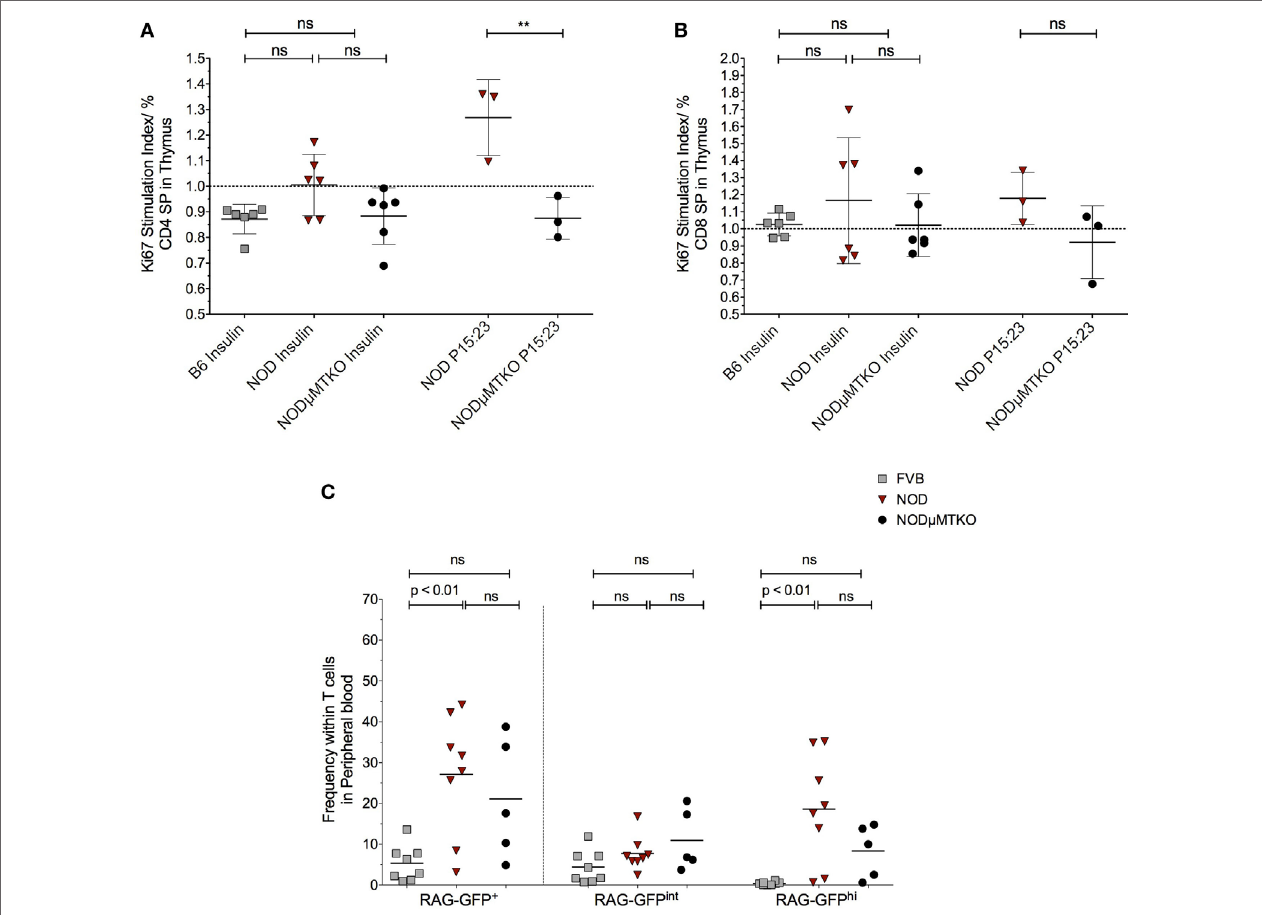
FigUre 7 | B cells promote premature thymic-release of T cells before negative selection. (a,B) Thymocytes from 11- to 12-week-old B6, non-obese diabetic (NOD) and NOD NOD- μ MTKO mice were stimulated with insulin or B15:23 peptide (NOD and NOD- μ MTKO mice, only) for 72 h and Ki67 expression in CD4SP (a) or CD8SP (B) cells as a measure of proliferation was determined by flow cytometry. The frequency of Ki67 + cells for stimulated samples was normalized against the frequency of Ki67 + cells in unstimulated samples. (c) Frequency of RTEs (RAG-GFP hi ) in peripheral blood of 11- to 12-week-old FVB-GFP ( n = 8), NOD-GFP ( n = 8), or NOD- μ MT − /– GFP ( n = 5) mice. Data are pooled from two independent experiments, and cells were analyzed on a live, single, CD3 + T cell gate. The data are presented as scatter plot, the bar representing the mean value; P values were calculated using the two-way ANOVA followed by Tukey multiple comparison test and are shown this figure; ns, not